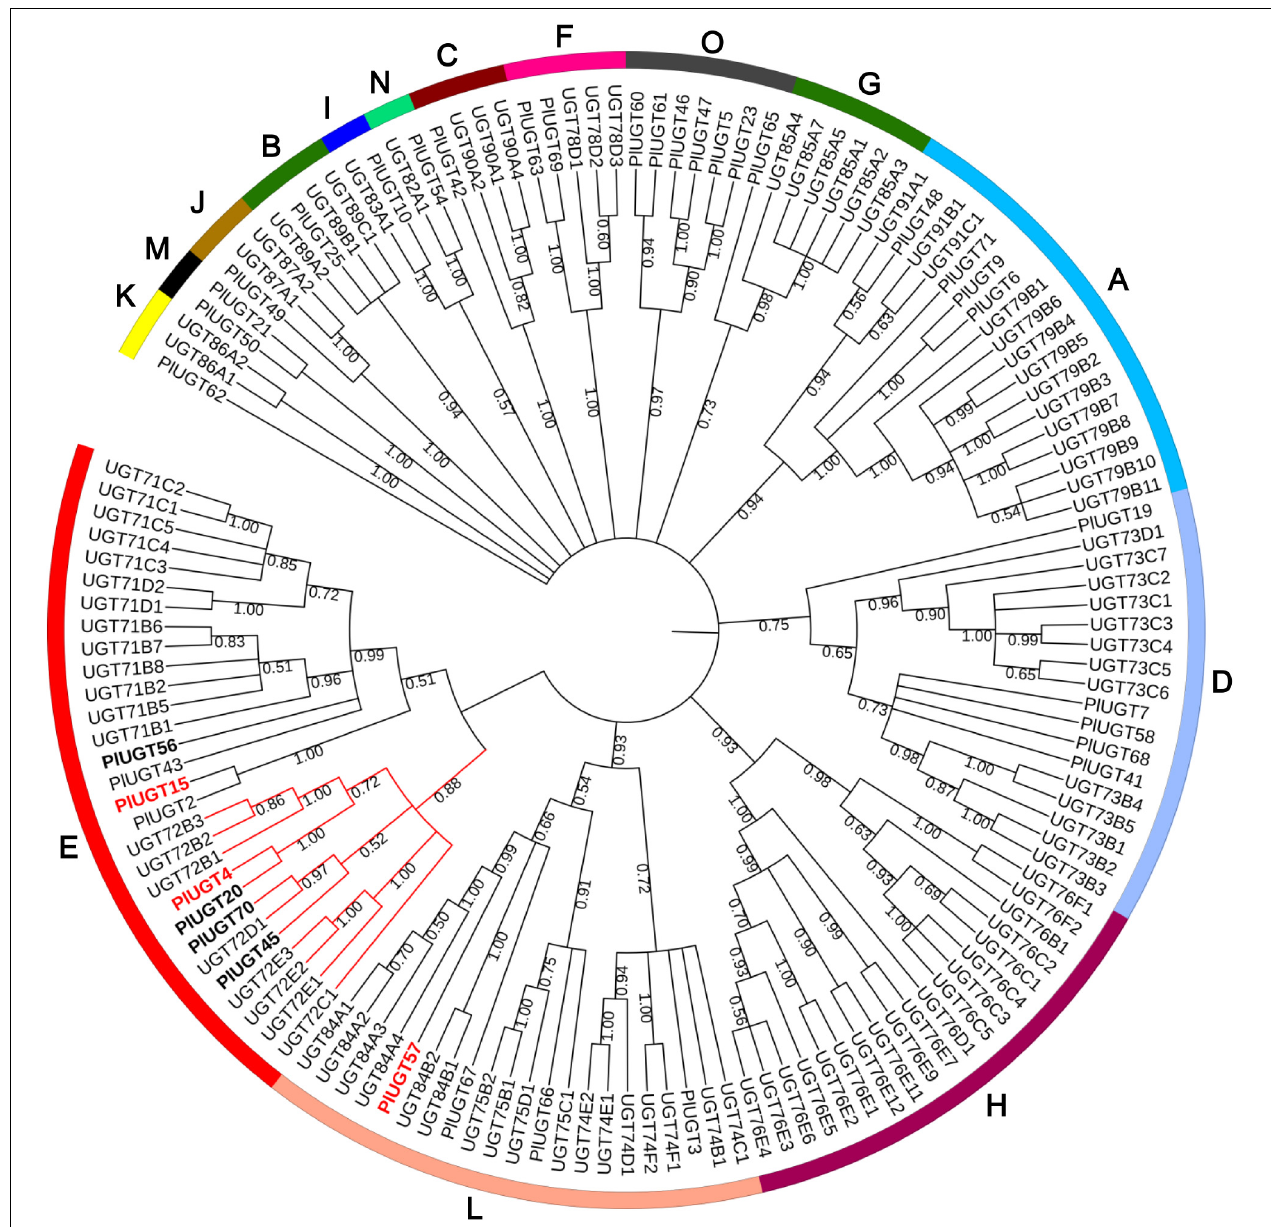
FIGURE 1 | Phylogenetic tree of UDP-sugar-glucosyltransferases (UGTs) from Pueraria lobata and Arabidopsis thaliana . The neighbor-joining tree was constructed by analysis of the 38 full-length PlUGTs and a set of AtUGTs using MEGA 7.0 software with 1000 bootstrap replicates. The protein names and accession numbers are listed in the Supplementary Table S2